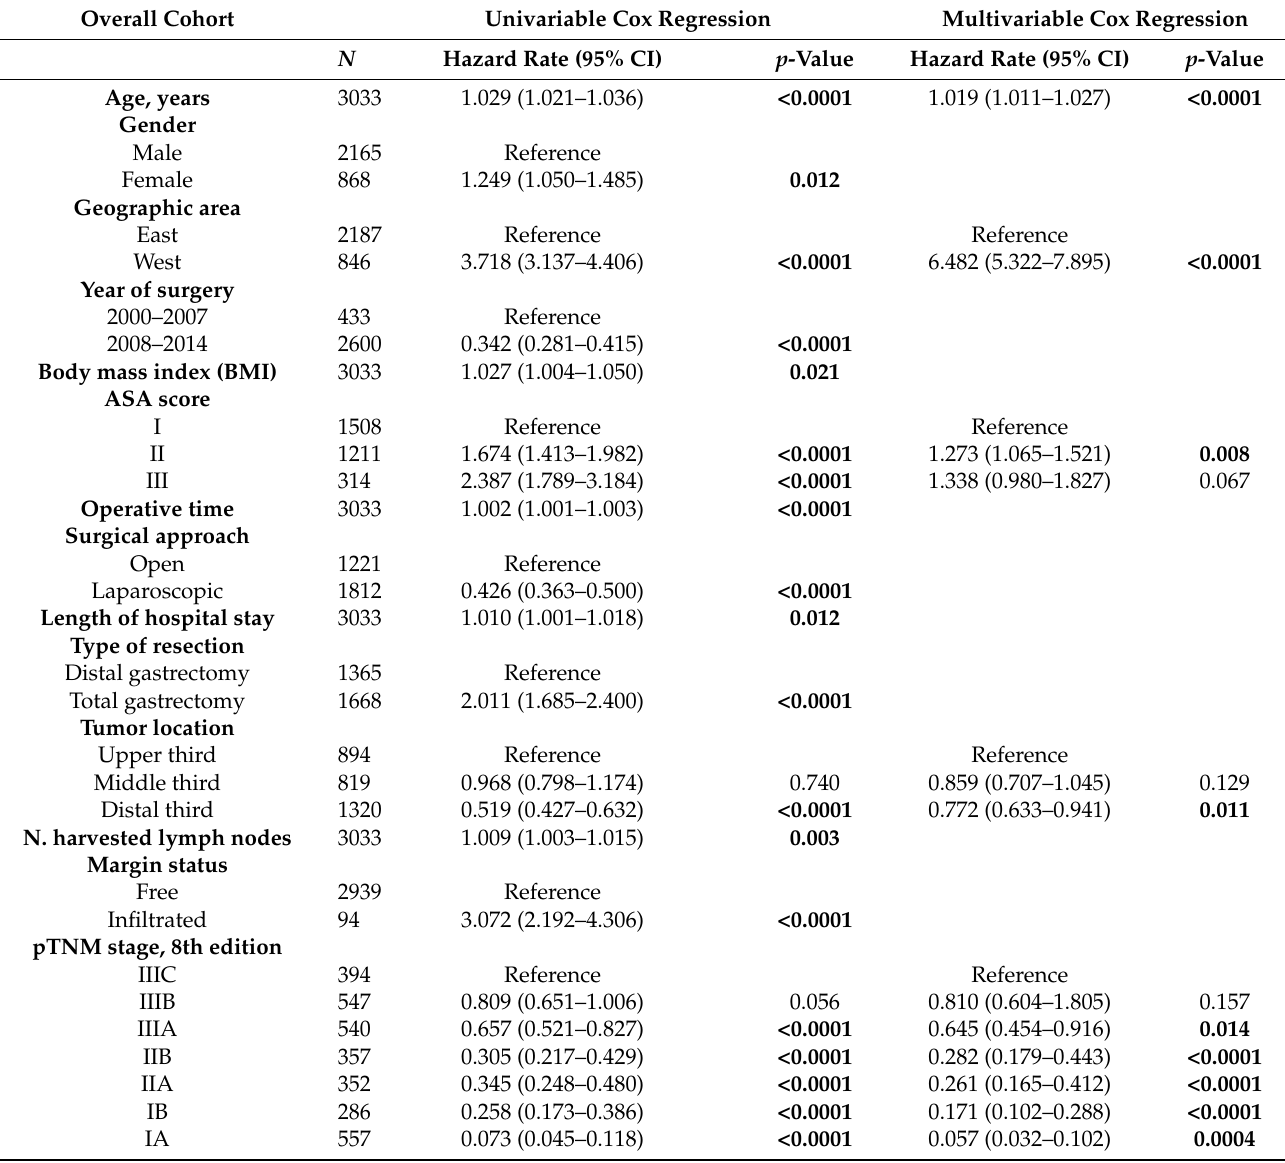
Table 5. Univariate and multivariate Cox regression for five-year overall survival, entire